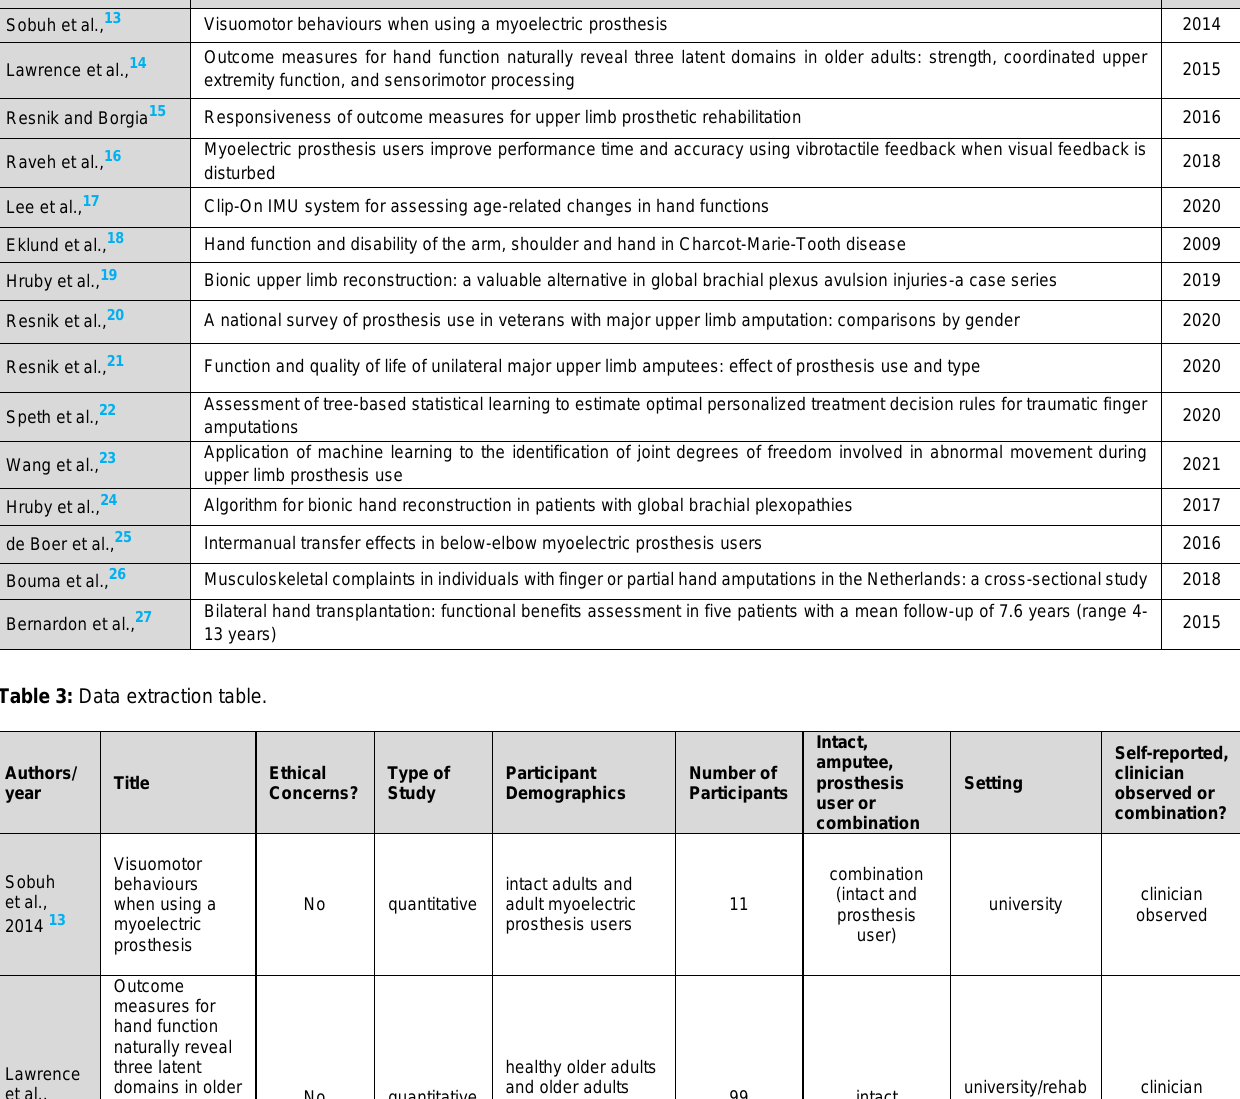
Table 2: List of included papers Authors Sobuh et al., 13 Visuomotor behaviours when using a myoelectric prosthesis Lawrence et al., 14 Resnik and Borgia 15 Raveh et al., 16